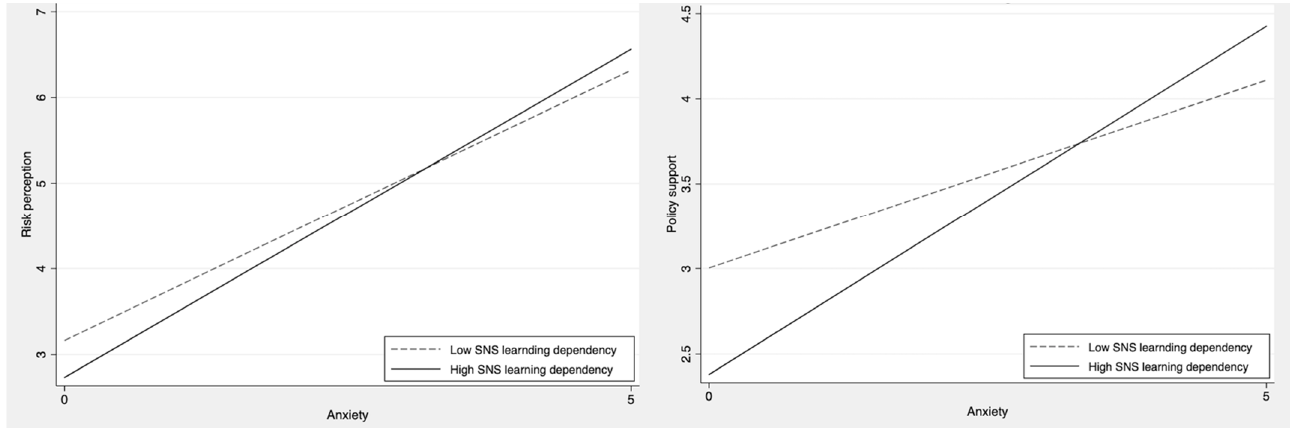
Figure 1. The effects of anxiety on risk perception (on the left ) and policy support (on the right ) moderated by SNS learning dependency.